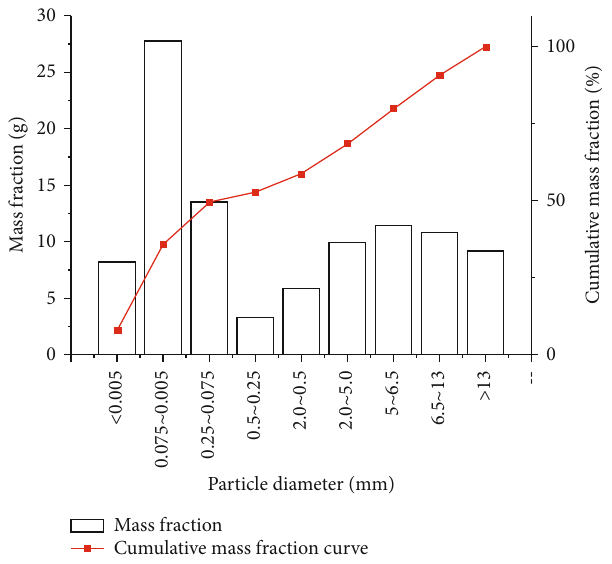
Figure 6: Particle-size distribution curve of medium-coarse sand layer.